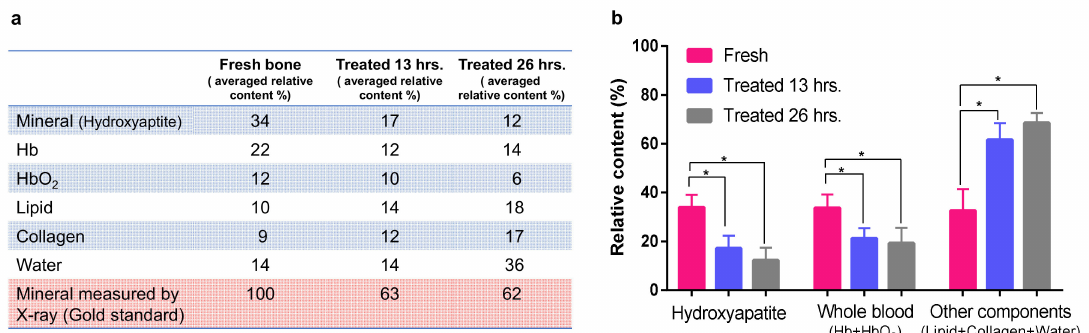
Figure 4. ( a ) Relative contents of the chemical components in the trabecular bone measured by multi-wavelength photoacoustic analysis (MWPA), including hydroxyapatite, deoxygenated hemoglobin (Hb), oxygenated hemoglobin (HbO 2 ), lipid, collagen, and water). ( b ) The relative contributions of the mineral (hydroxyapatite), whole blood (Hb + HbO 2 ), and other components (lipid + collagen + water) calculated from ( a ); * stands for p <